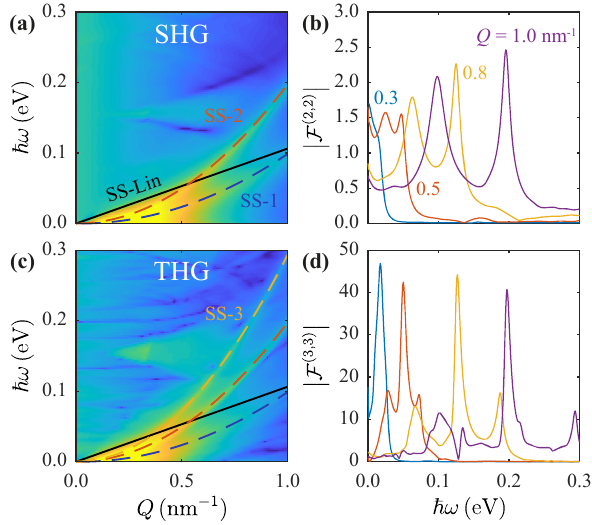
Figure 4: Shockley states in the nonlinear optical response. (a) Calculated dispersion diagram of SHG in the low Q and 𝜔 corner, revealing a nonlinear enhancement that involves Shockley states. The solid black line (SS-Lin) indicates the position of the SS acoustic plasmon demonstrated in the linear response and obtained from ref [ 59 ], whereas in SHG two resonances emanate at a different position than SS-Lin and are indicated by the dashed blue and red parabolic curves. (b) Low-frequency nonlinear FoM spectra for selected Q , indicated by the color-coded curves, in which surface-state features are clearly resolved. Panels (c) and (d) show the THG field and corresponding FoM in the same parameter space as panels (a) and (b), respectively. A third parabolic feature is indicated by the dashed yellow curve in (c). All curves are parametrized in Table 1